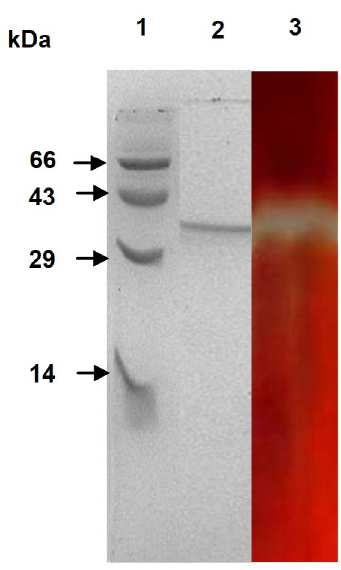
Fig. 2. Analysis of the purified enzyme by SDS-PAGE and zymography. SDS-PAGE (12%) with Coomassie staining. Lane 1- molecular weight markers. Lane 2- The purified enzyme. Lane 3- Zymography with Konjc-glucomannan as the substrate white band indicate β-mannanase